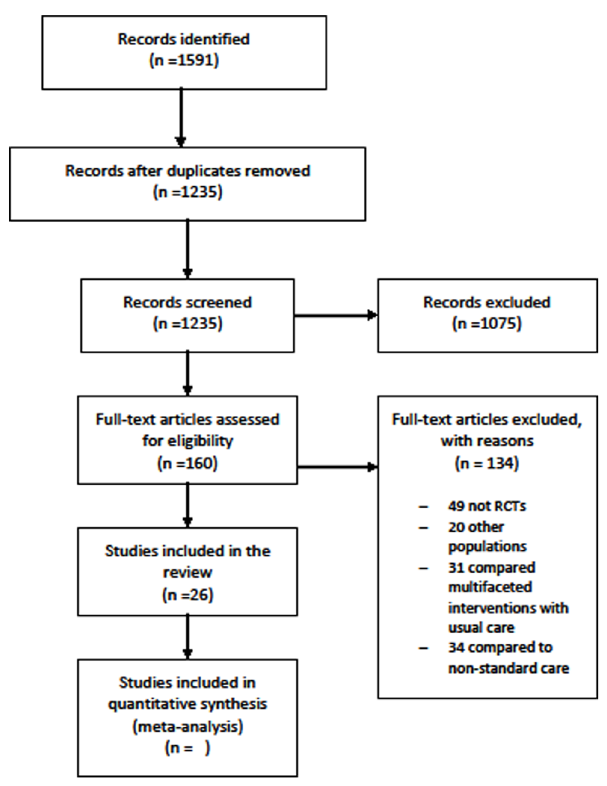
Figure 1. Modified PRISMA diagram.